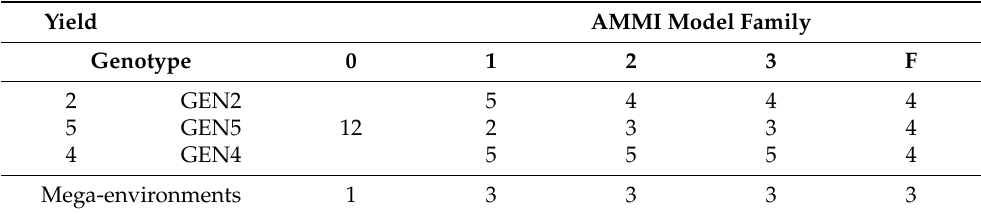
Table 5. AMMI family models for the grain yield dataset, showing the best-suited genotypes and the number of